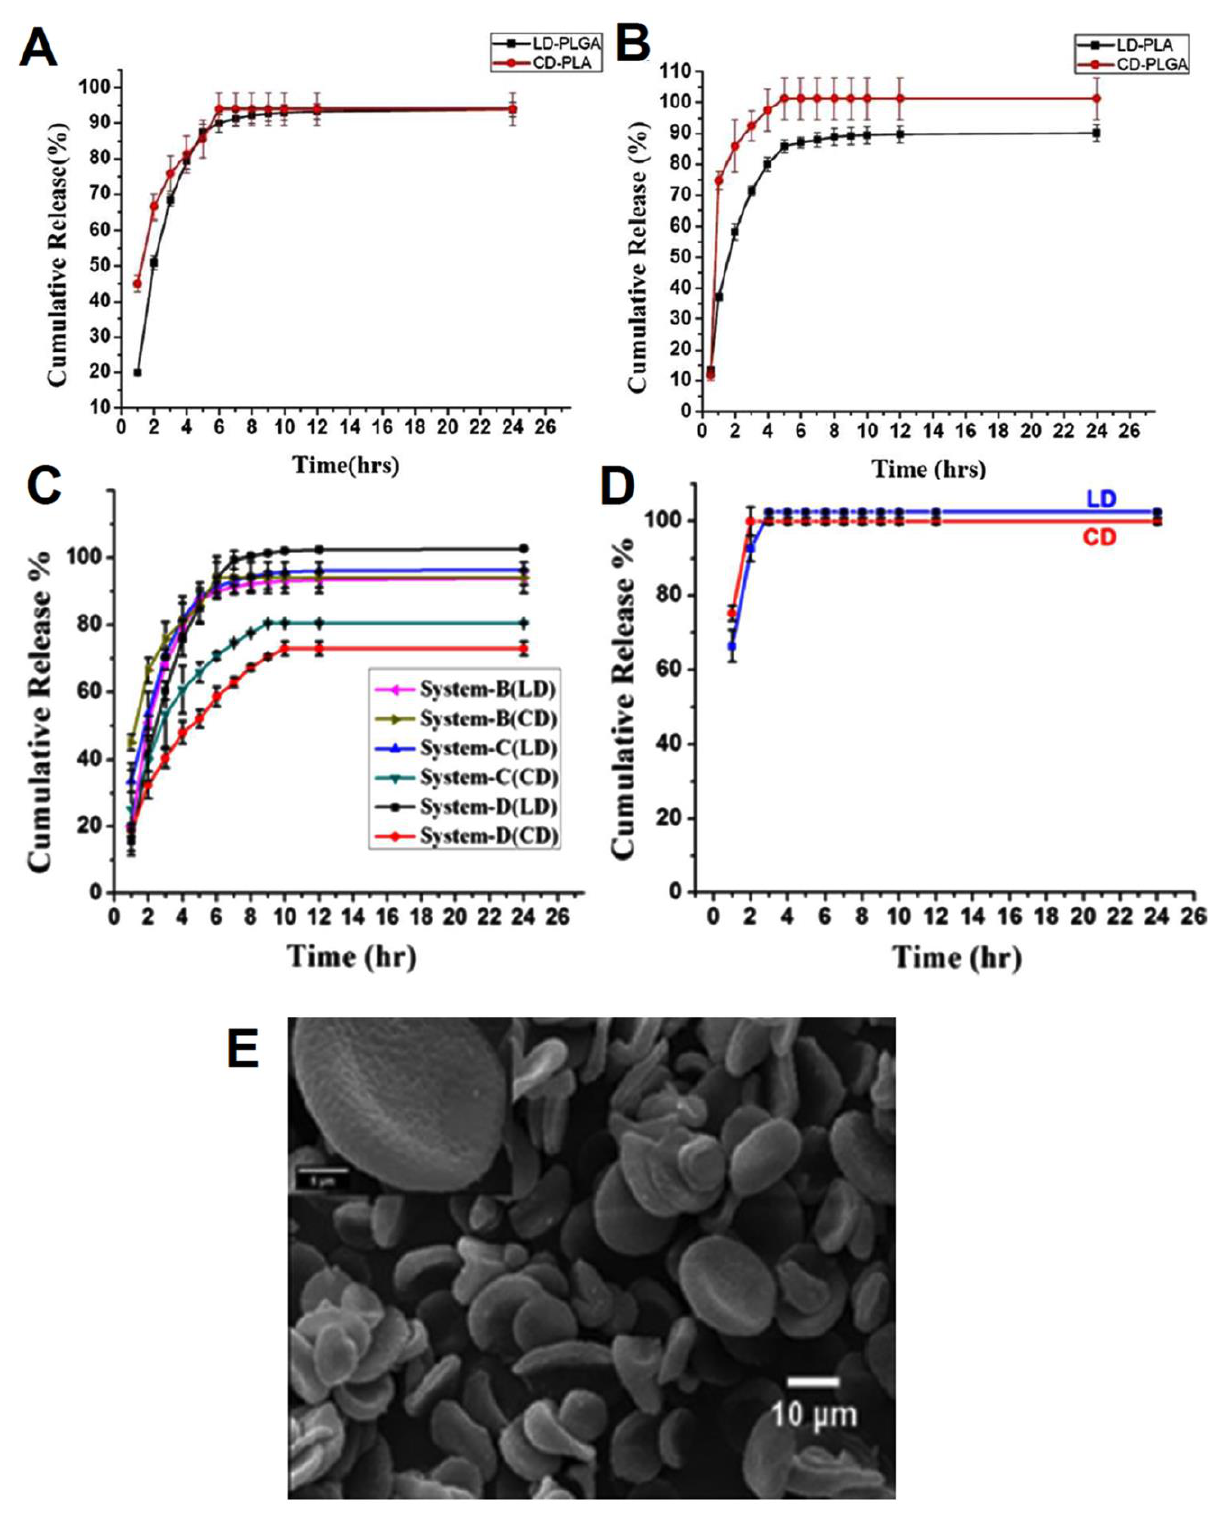
Figure 11. LD and CD release profiles from ( A ) system A and ( B ) system B. ( C ) LD and CD release rate comparison in systems B, C, and D. ( D ) The dual-drug release from the Syndopa tablets in SGF for 5 h + 24 h in SIF. ( E ) SEM analysis pictures of the disc-shaped dual-compartment materials. Reproduced from Parthipan et al. [187], with permission from Springer Nature.